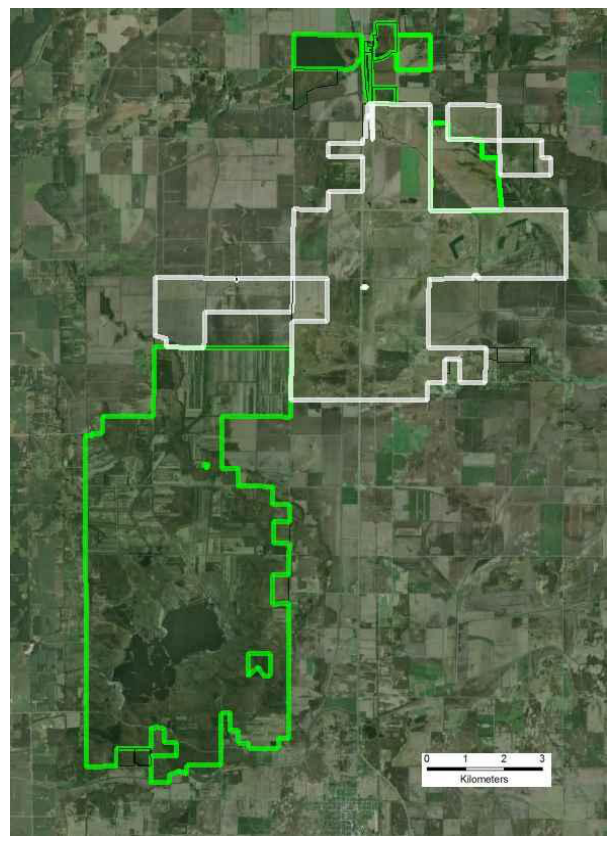
Figure 3. Air Photo of the Efroymson Restoration at Kankakee Sands demonstrating the dominance of agriculture in the region surrounding the restoration. The land conversion at the site is typical for many grain producing areas across the Midwestern United States. The restoration is outlined in white while pre-existing conservation areas are outlined in